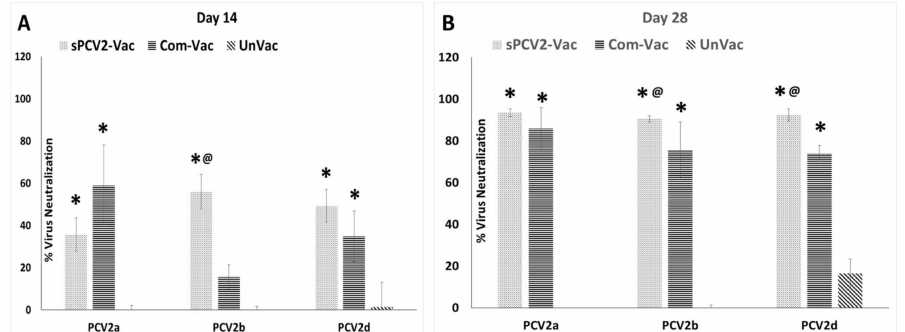
Figure 6. Virus neutralization responses in vaccinated pigs: Mean percentage virus neutralization as measured by a rapid fluorescent focus inhibition test at ( A ) 14 days post-vaccination ( B ) 28 days post-vaccination measured against a heterologous PCV2a strain, homologous PCV2b strain, and heterologous PCV2d strain. X -axis—experimental groups, Y -axis—percentage virus neutralization, dots—sPCV2-Vac, horizontal lines—commercial vaccine, slanted lines—unvaccinated group, * signifi- cantly different from the unvaccinated control group by the Student’s t -test at p ≤ 0.05, @ significantly different from the commercial vaccine control group by the Student’s t -test at p ≤ 0.05. Error bars represent the standard deviation.